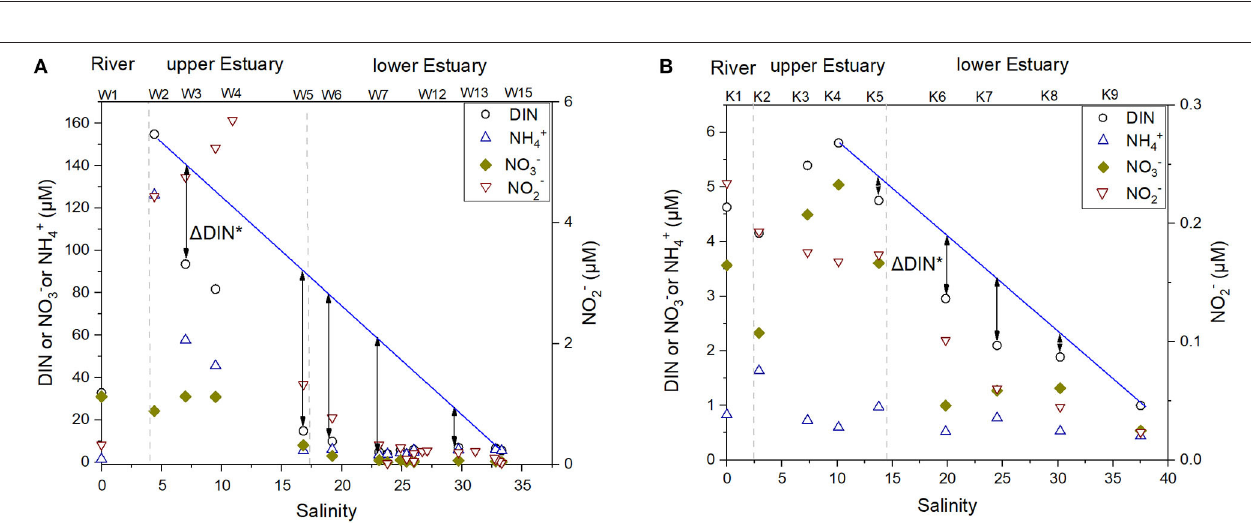
FIGURE 3 | Dissolved inorganic nitrogen (DIN), ammonium, nitrate, and nitrite variation along salinity of the surface waters in (A) the WRE and (B) the KRE. Note the scales of the Y-axes for the two estuaries are different. The blue lines are the linear regression between highest DIN and marine end-member DIN. The differences between the measured values and values on blue lines, namely 1 DIN*, indicate the amount of DIN that is removed during respective estuarine transport after the presence of maximum DIN in the upper estuaries.